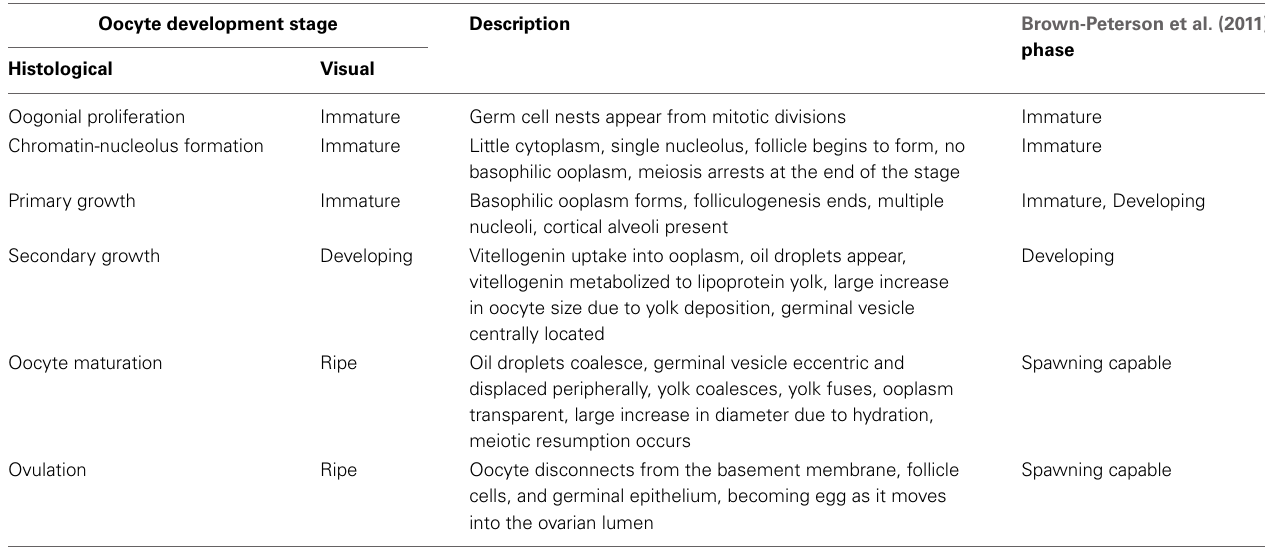
Table 3 | Developmental stages for histological analysis of female fish based on applying criteria developed by Grier et al. (2009) to the most advanced oocytes observed and the presence of post-ovulatory